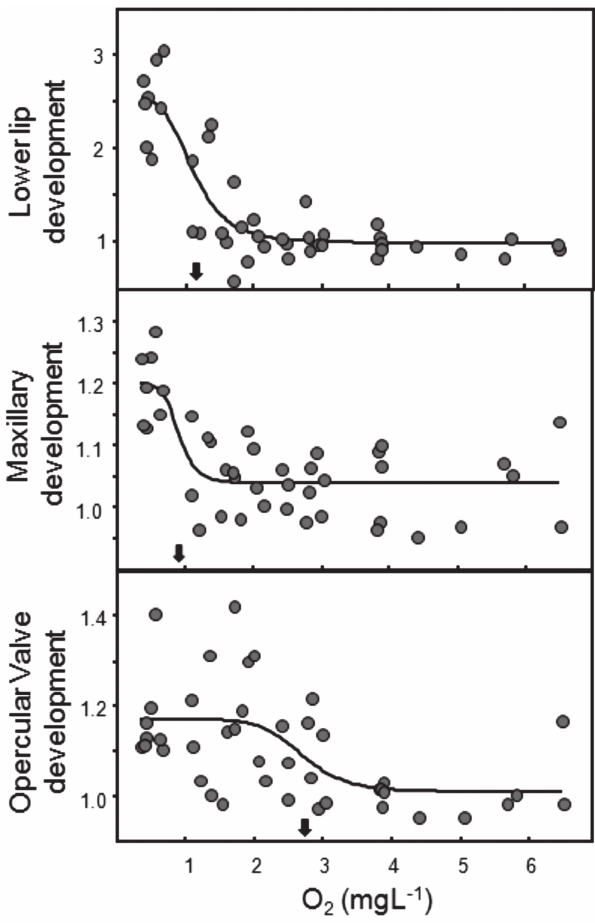
Fig. 3. Response curves of three morphological variables of Piaractus mesopotamicus (proportion of increase) respect to dissolved oxygen gradient. Black arrow indicates the DO concentration determined for the inflection point of the reaction